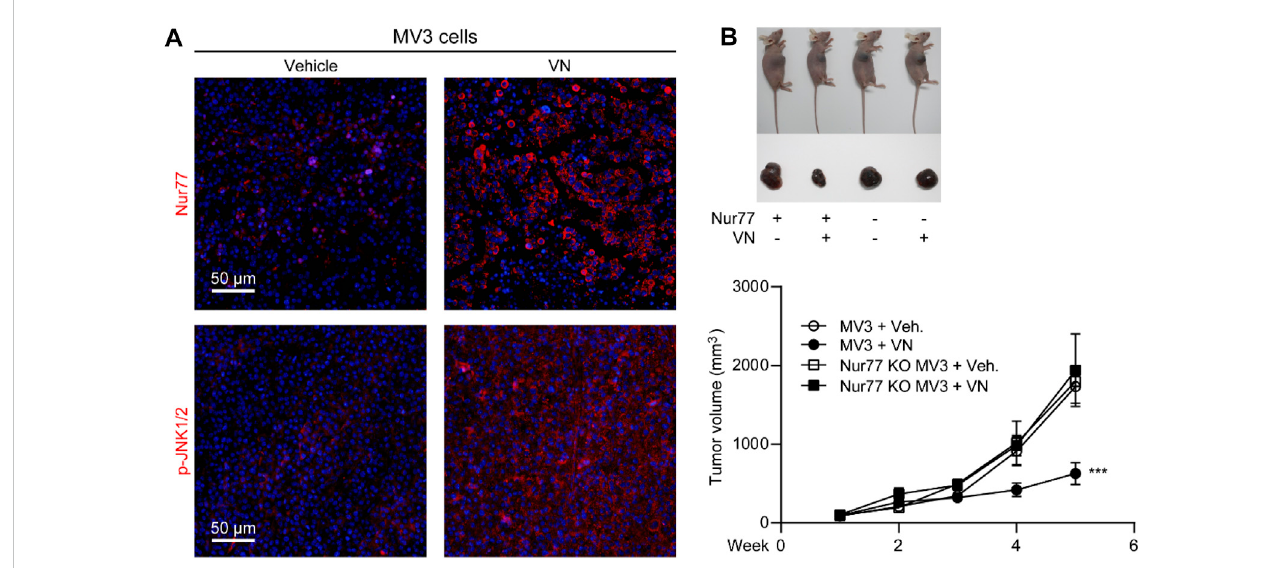
FIGURE 6 Anti-canceref fi cacyofvenlafaxineinmice.BALB/cnudemicebearingMV3orNur77KOMV3xenografttumorsweretreatedwithvenlafaxine(20 mg/kg, i.p.) or its vehicle once daily from week 1 to week 5 after implantation of MV3 or Nur77 KO MV3 cells. (A) Tumor tissues were immunostained with Nur77 and JNK1/2 antibodies and visualized by confocal microscopy. (B) Venlafaxine reduced cancer cell growth in nude mice through Nur77. One of fi ve similar experiments is